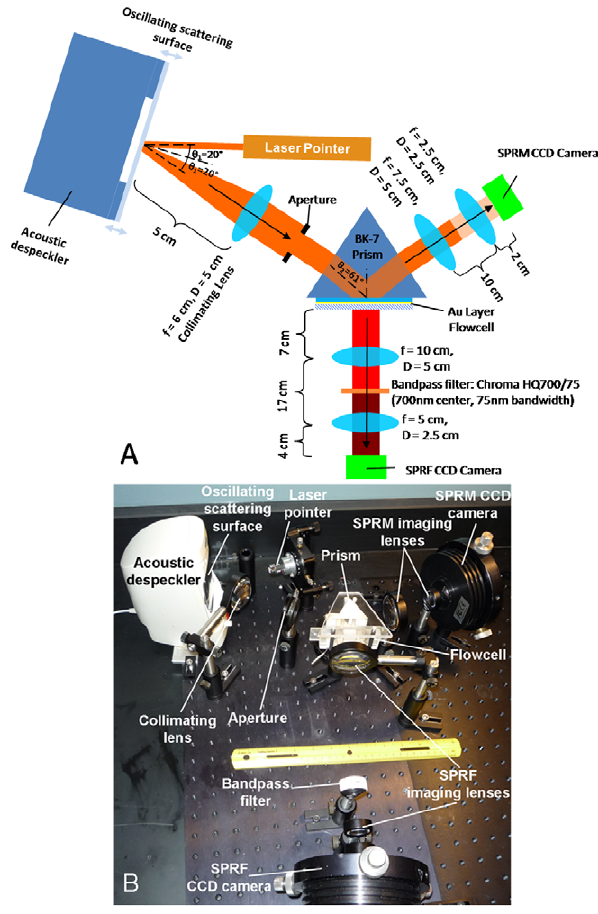
Figure 1. System Overview. Top view schematic (A) (not to scale) and photograph (B) of the instrument with the sample oriented horizontally.